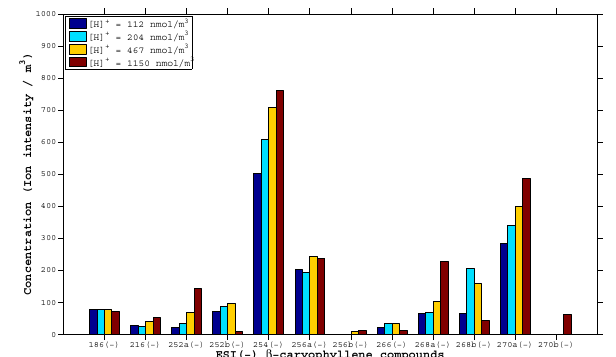
Fig. 2. Concentration of compounds detected by ESI in negative ion mode in the series of β -caryophyllene/NO x irradiation experiments. Chemical formulas and proposed chemical structures of these com- pounds are given in Table